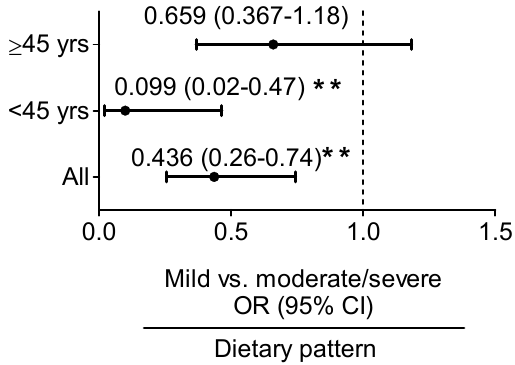
Figure 3. Age-adjusted odds ratio (OR) and 95% confidence interval (CI) for predicting mild vs. moderate and severe fatty liver according to the serum iron:ferritin-specific dietary pattern score determined using reduced rank regression. ** p < 0.01 indicate statistical significance.